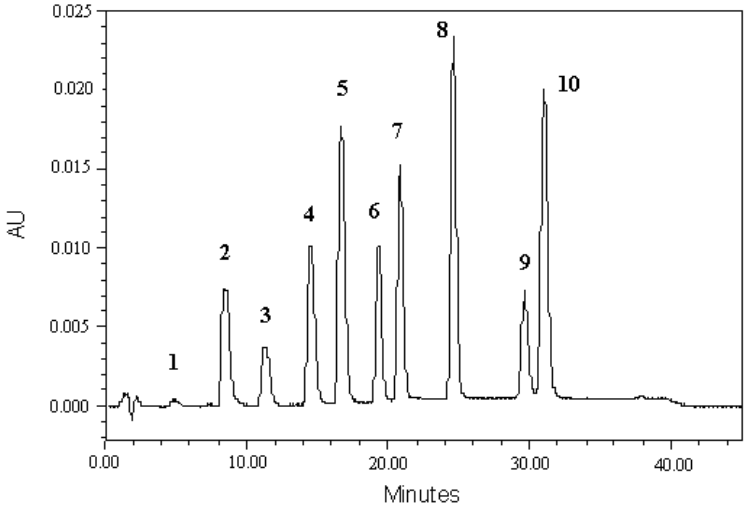
Figure 2. HPLC chromatogram of standard mixture of indole compounds (50 µM for each compound) at 280 nm. Peak identities: 1, indole-3-acetic hydrazide; 2, acetamide; 3, indole-4-carboxylic acid; 4, indole-5-carboxylic acid; 5, indole-3-carboxylic acid; 6, IAA; 7, 3-acetylindole; 8, indole-6-carboxylic acid; 9, indole-3-pyruvic acid; 10, indole-2-carboxylic acid. Note: Injection volume was 5 μL. HPLC running conditions were described in Sections 2.2 and 3.1.